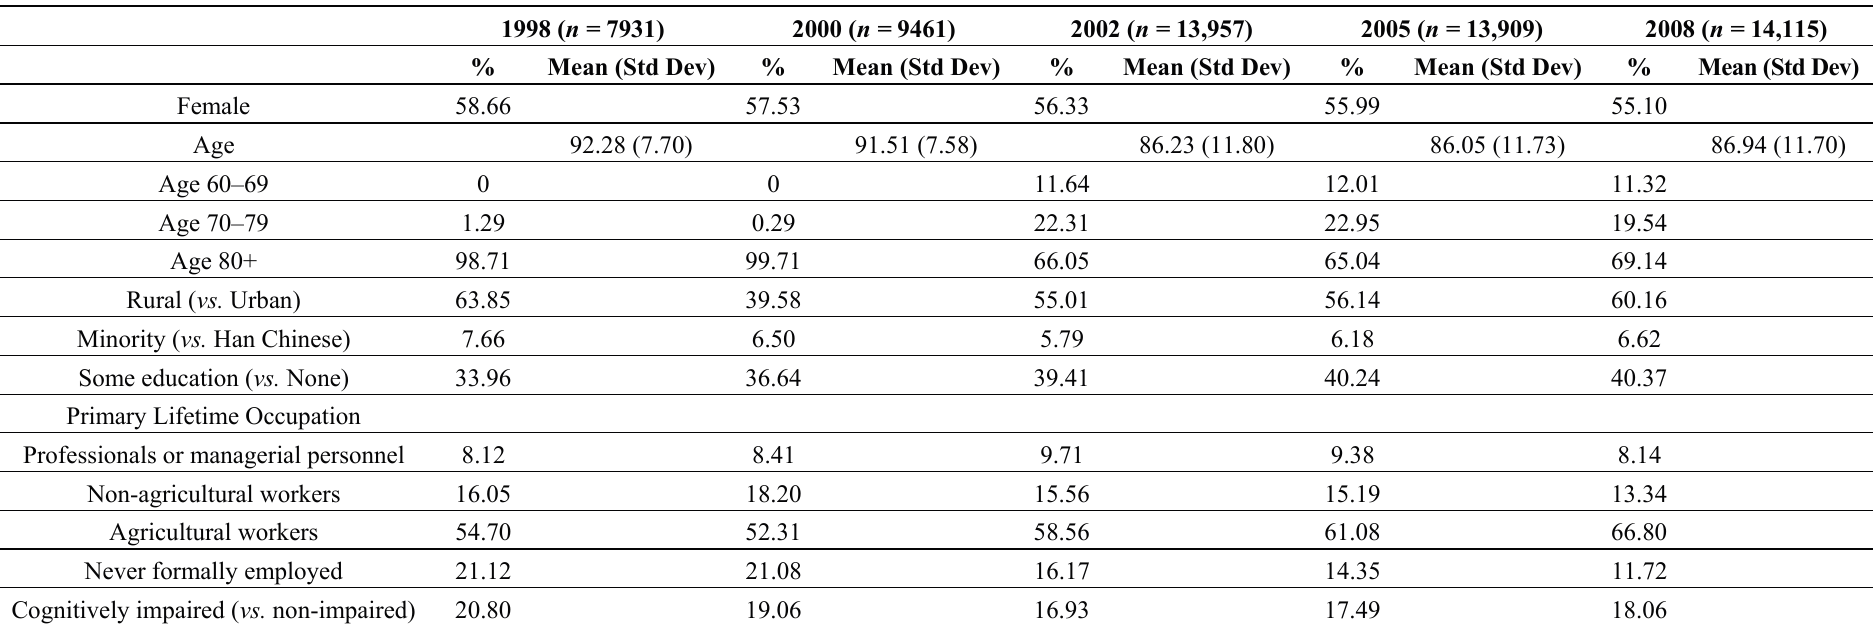
Table 1. Characteristics of the